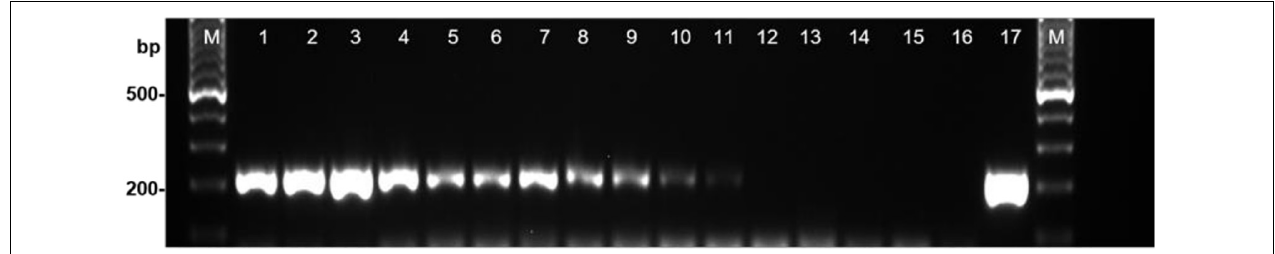
FIGURE 1 | Detection of Stagonosporopsis cucurbitacearum from squash seed samples with different levels of infestation using PCR with primer pair DBF1/DBR1. Lanes 1–12: decreasing incidence of contamination (see Table 1 ): T85, T92, T9, T4, T86, T95, T96, T87, T93, T12, T90 and T101 (local healthy seed). Lane 13, commercial healthy seed (IHS); lane 14, water control (WC); lane 15, Curvularia spicifera (isolate B170); lane 16, Phoma sp. (isolate Ph39); lane 17, S . cucurbitacearum (isolate D33). M: Ladder, 100-bp.